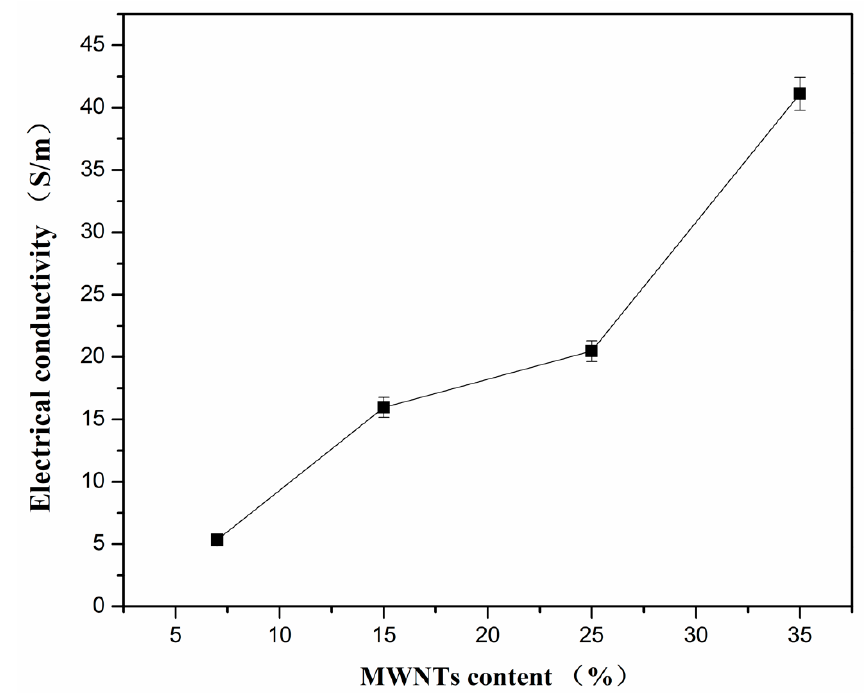
Figure 5. Electrical conductivity of PVDF composites with different content of MWNTs at room temperature.